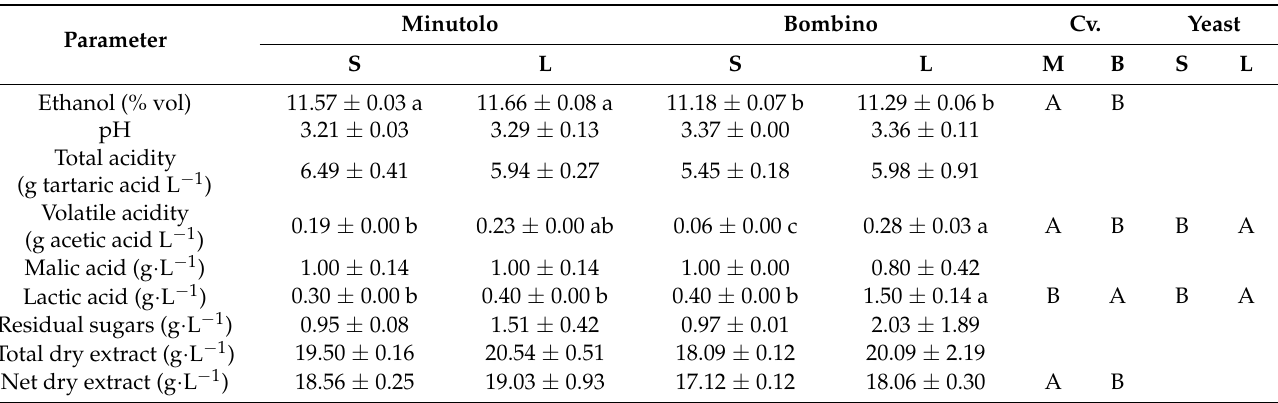
Chemical analyses of the wines obtained by the combination of grape cul- tivars (Cv. M—Minutolo and B—Bombino) and yeast starters (S— Saccharomyces cerevisiae , L— Lachancea thermotolerans ). For each parameter measured (n = 2), the values indicate mean ± standard deviation; different capital letters indicate significantly different means (one-way ANOVA, main effects, p < 0.05); different lowercase letters indicate significantly different means (two-way ANOVA, interactions, p <